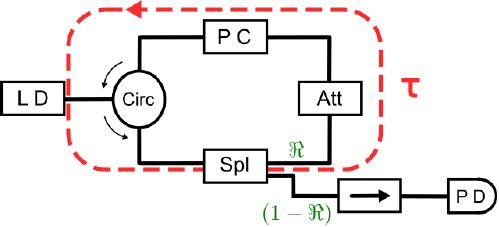
Figure 1. Scheme of our typical experimental setup to study feedback dynamics. LD: laser diode, Circ: optical circulator, PC: polarization controller; Att: optical attenuator, Spl: one by two intensity splitter with R = 0.95 and (1 − R ) = 0.05 splitting ratios, → : optical isolator, and PD: